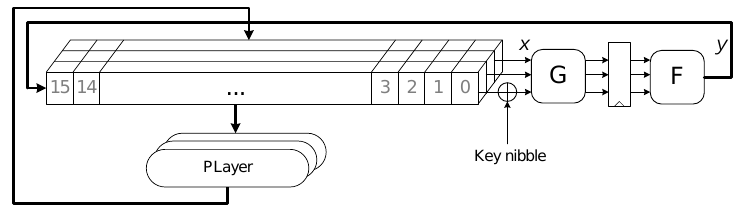
Figure 6: 3-share PRESENT TI architecture used for the